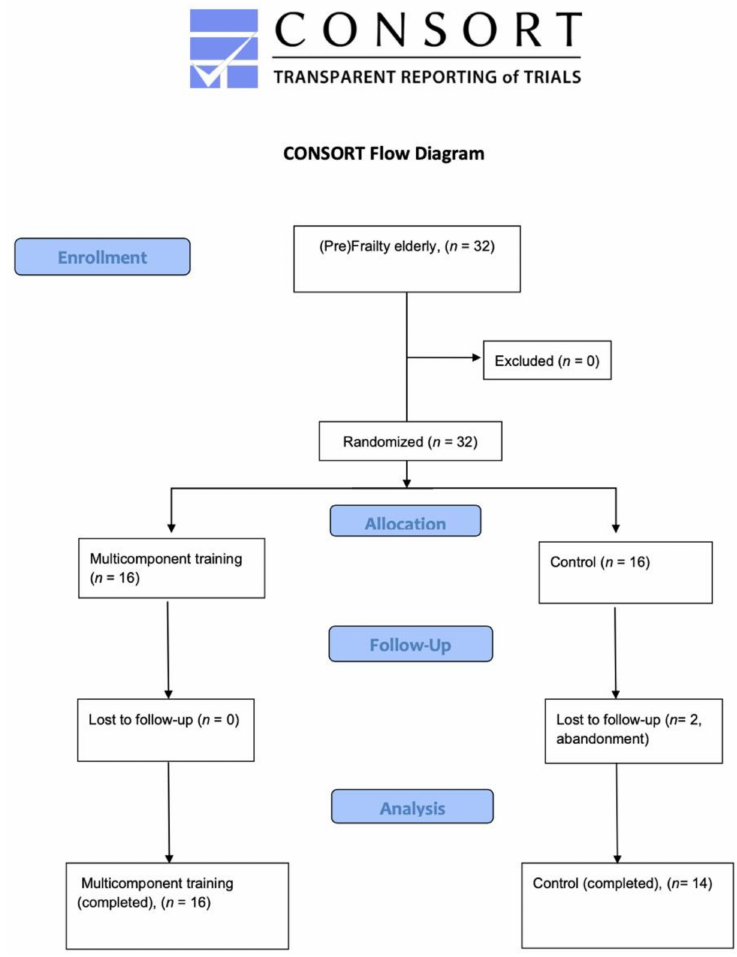
Figure 1. Flow chart